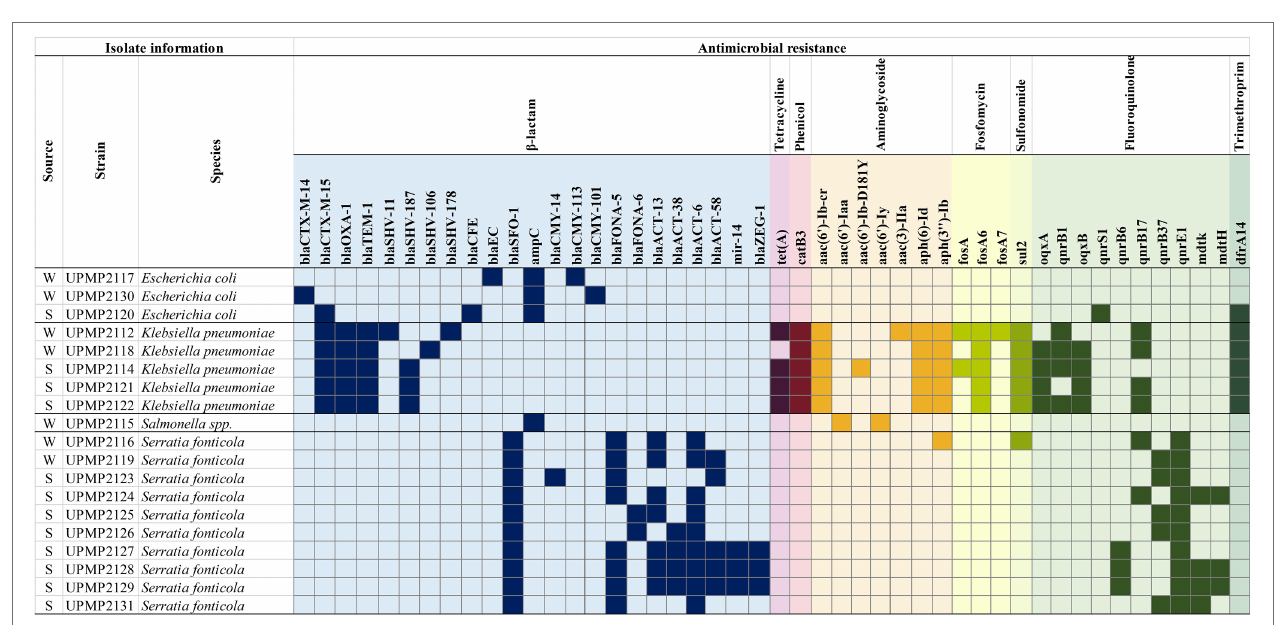
FIGURE 1 | Antimicrobial resistance (AMR) genes present in Enterobacterales isolated from water and spinach from farm to retail. W, water; S, spinach.